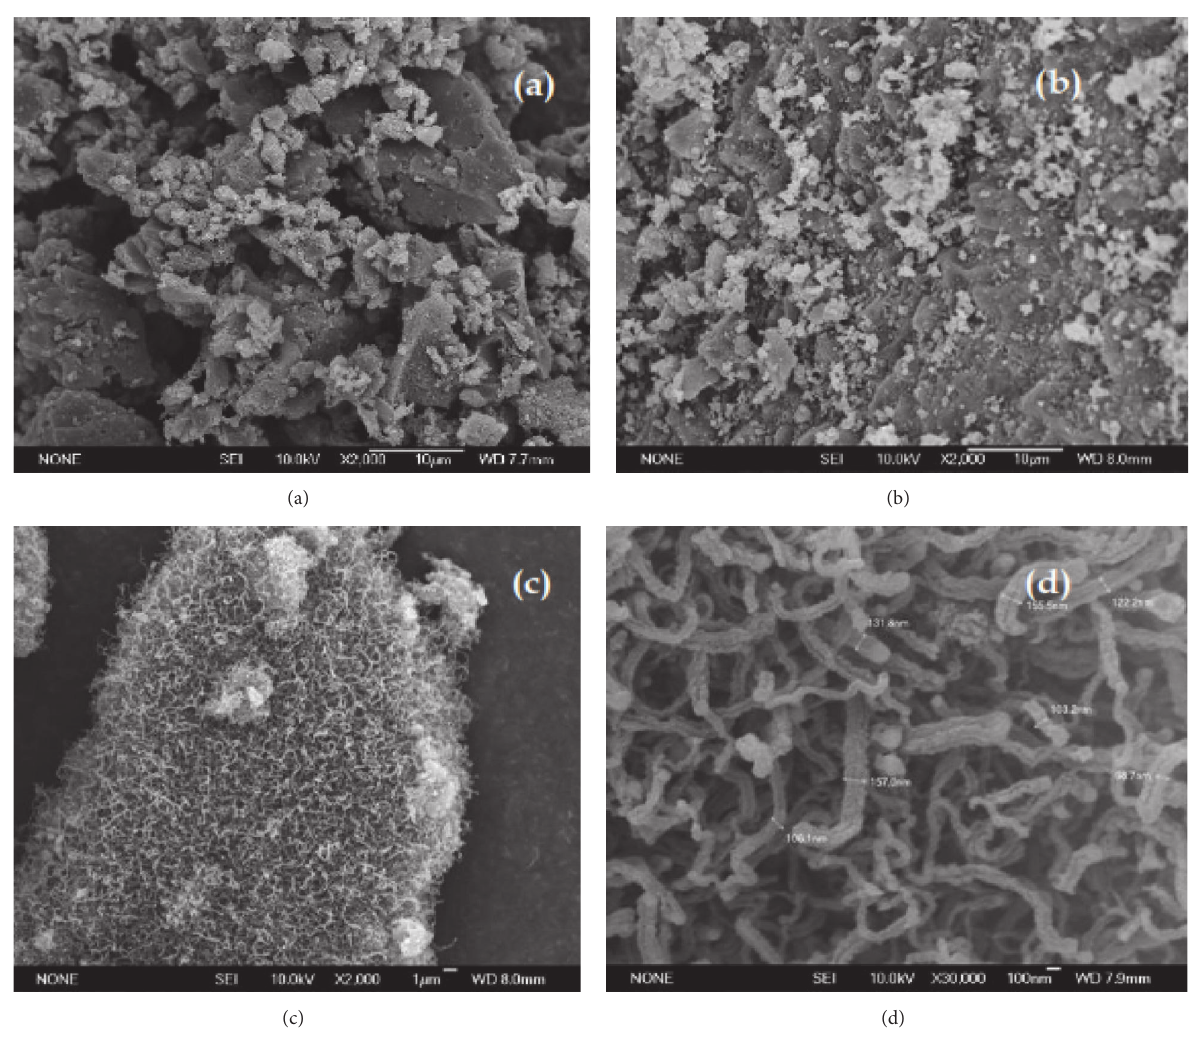
Figure 3: Scanning Electron Microscope images: (a) raw PAC, (b) Ni impregnated PAC, and (c) (d) CNF grown on PAC at optimized conditions.